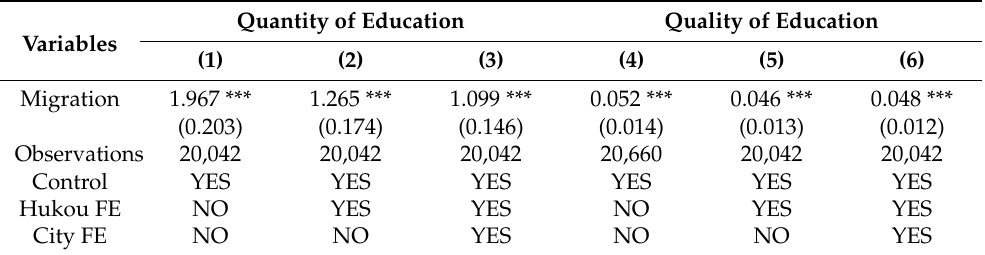
Table 3. Mechanism analysis based on the quality and quantity of adolescent